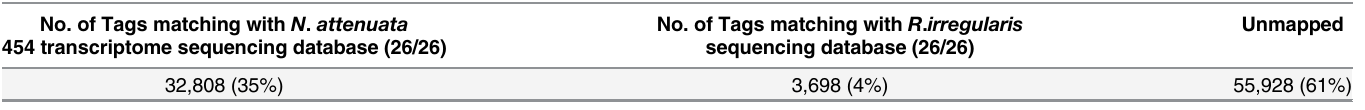
Table 1. Annotation of SuperSAGE Tags using the in-house N . attenuata 454 transcriptome database [57] and the publicly available Rhizophagus irregularis sequencing database [34]. No. of Tags matching with N . attenuata 454 transcriptome sequencing database (26/26)